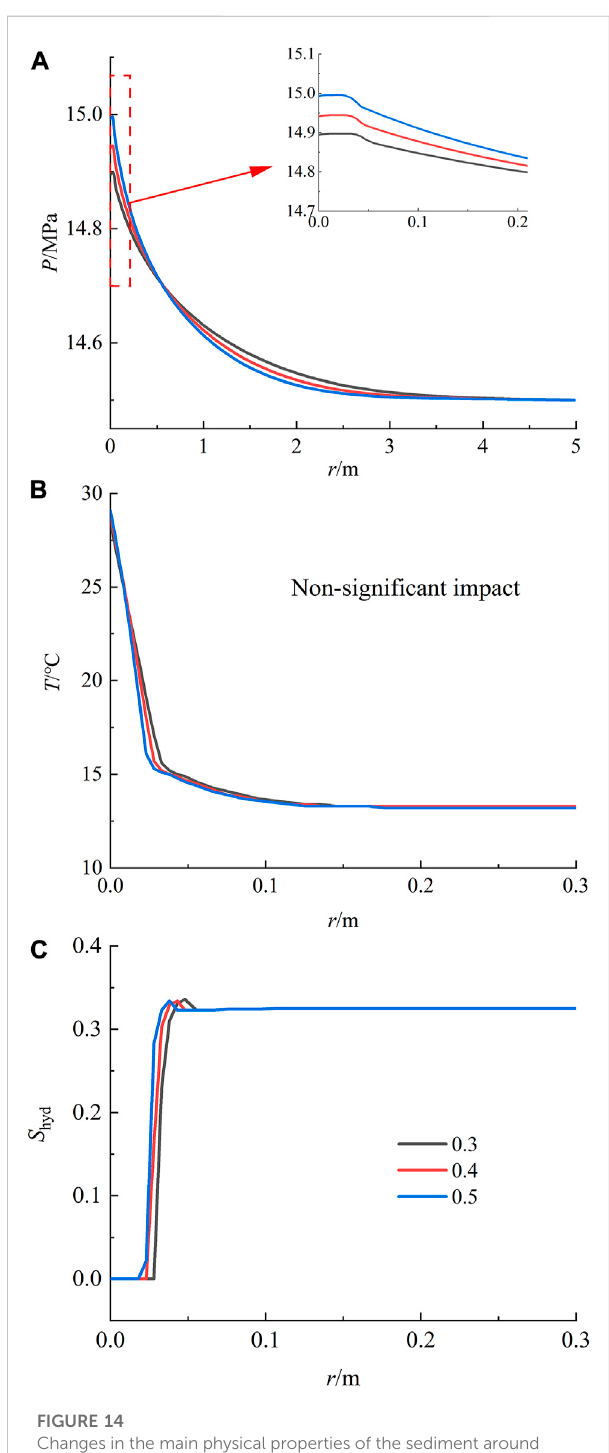
FIGURE 14 Changes in the main physical properties of the sediment around the wellbore at 25 min under different porosities. (A) Pressure. (B) Temperature. (C) Hydrate